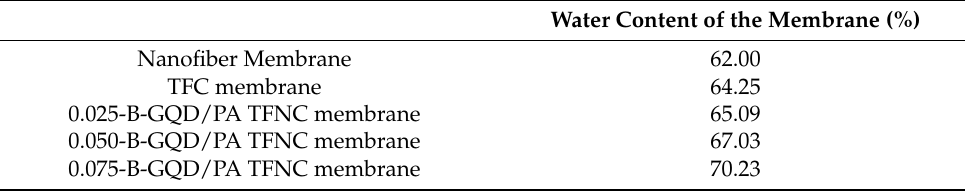
Table 1. Water content analysis of TFC and TFNC